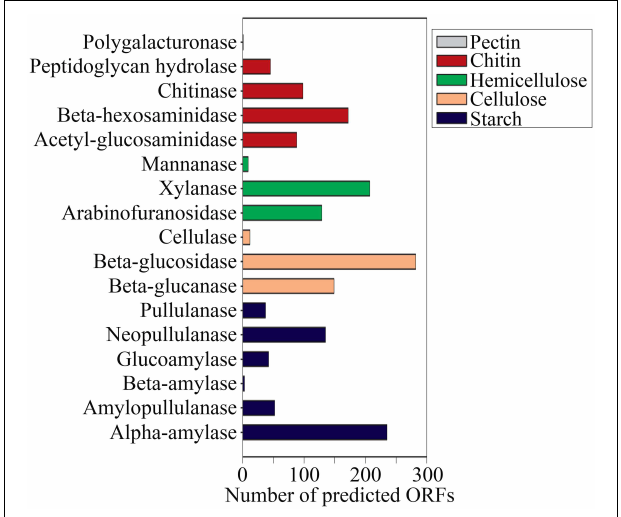
FIGURE 6 | Gene mining for enzymes involved in carbon (polysaccharides) degradation.